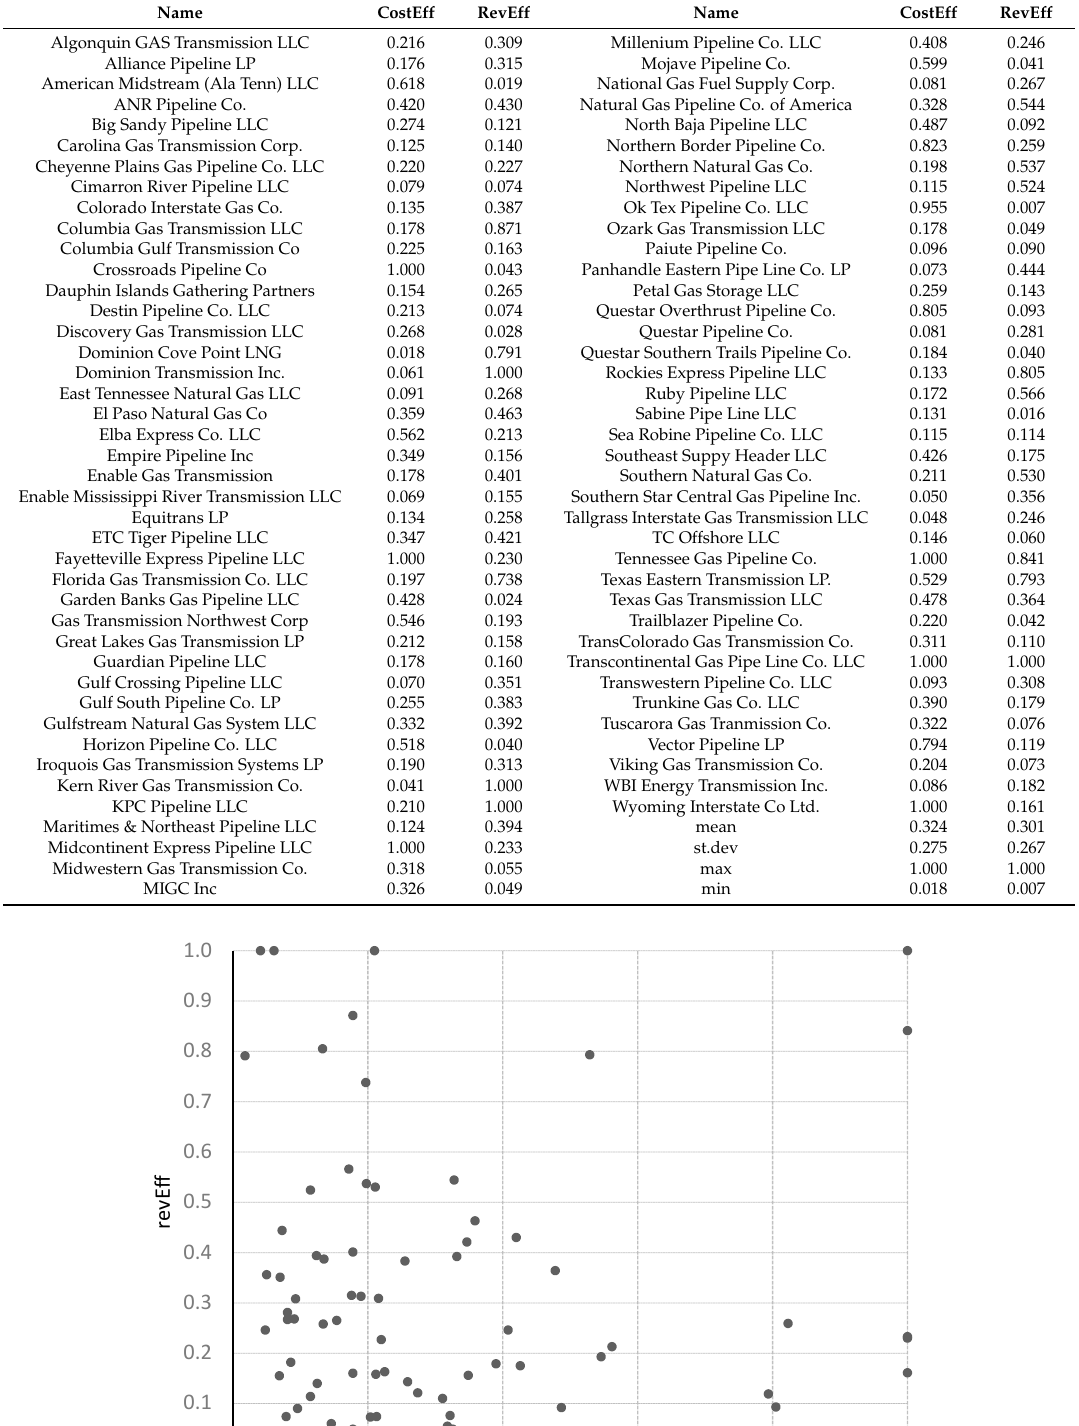
Table 3. Efficiencies for the two DEA models.